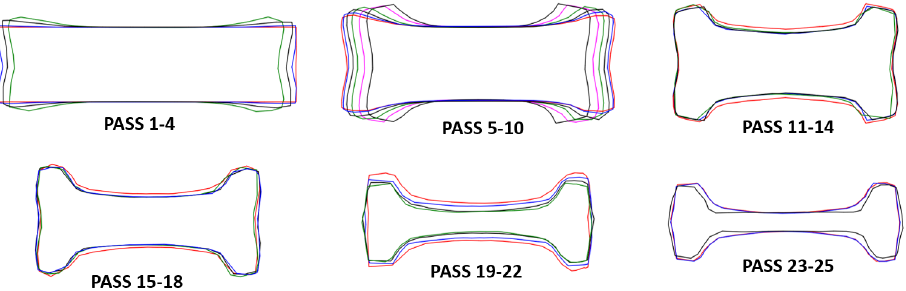
Figure 12. Geometry of the cross-sectional area at the center of the beam after each pass for the simu- lation at real temperature.